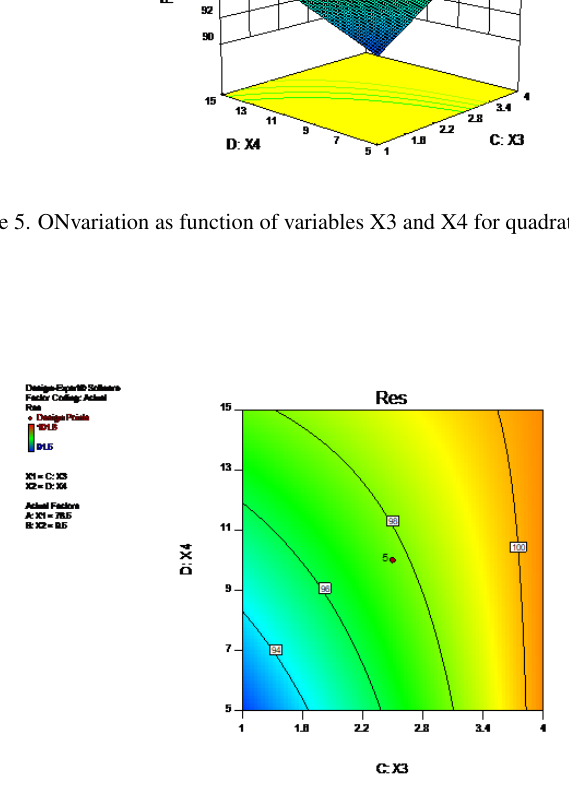
Figure 6. Contourlines for dependence of ON on variables X3 and X4 for quadratic model